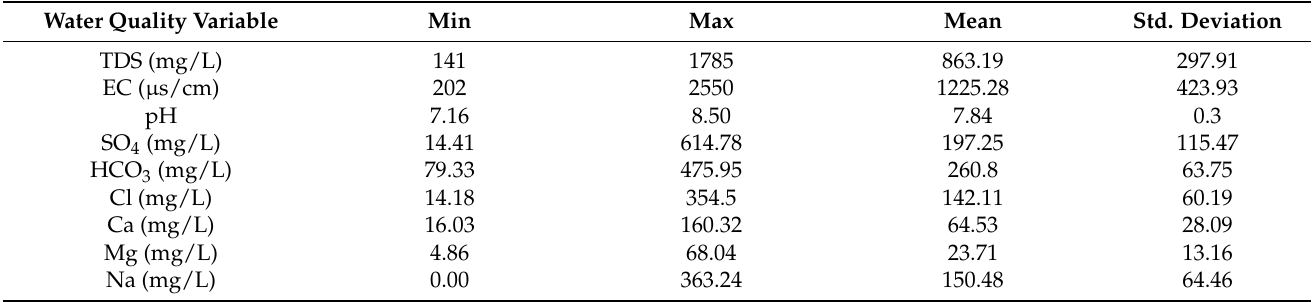
Table 1. Statistics of the water quality variables for the source study